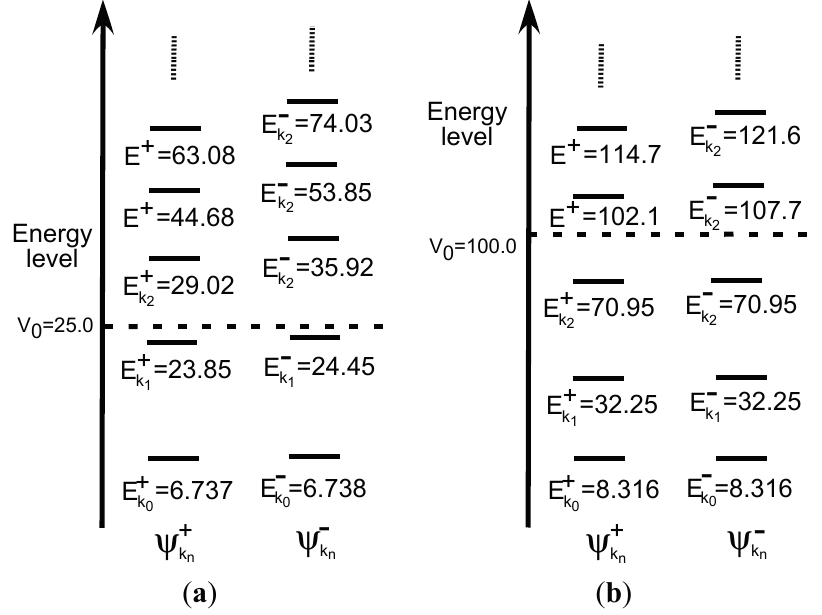
Figure 4. Energy level of double-well potential systems. ( a ) V 0 = 25. ( b ) V 0 =